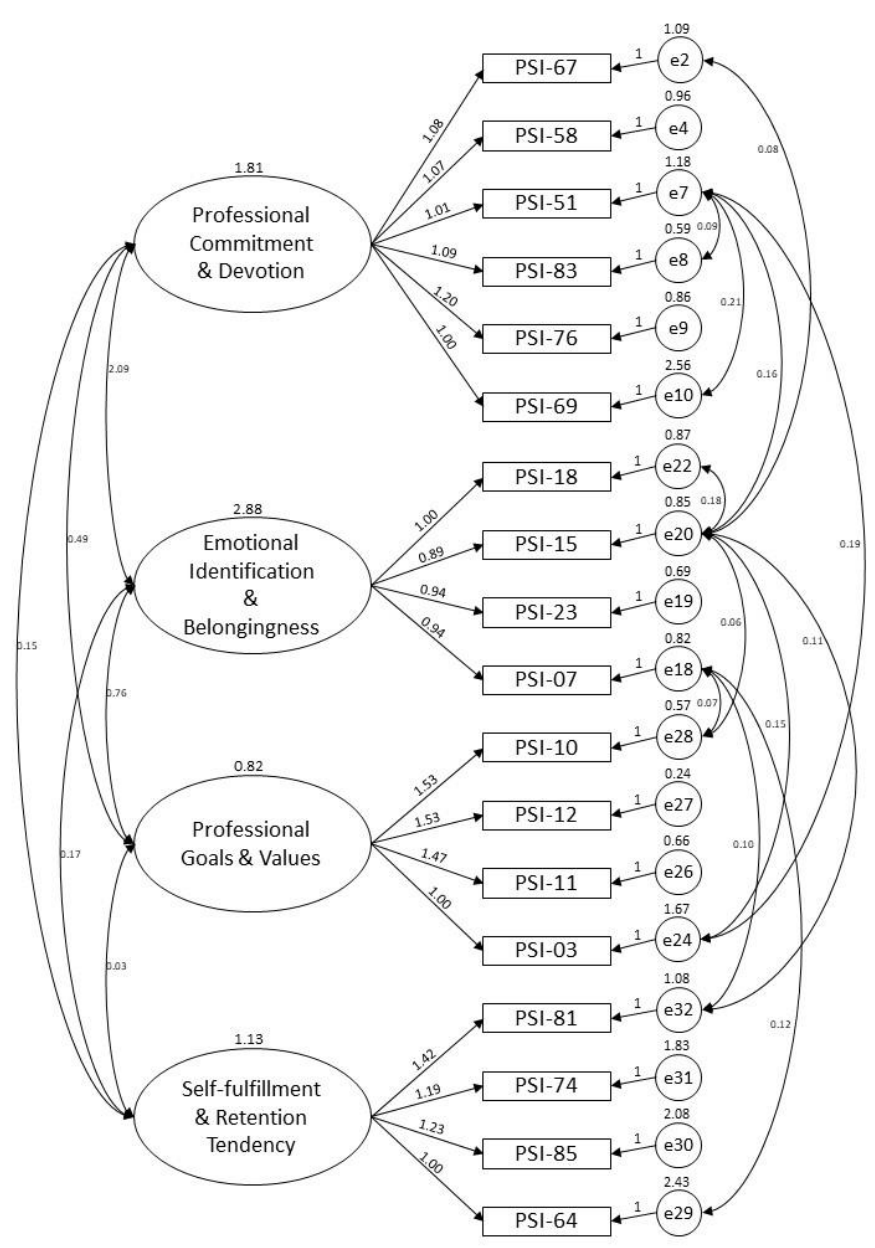
Figure 2. CFA model for the PIS-HSP scale.